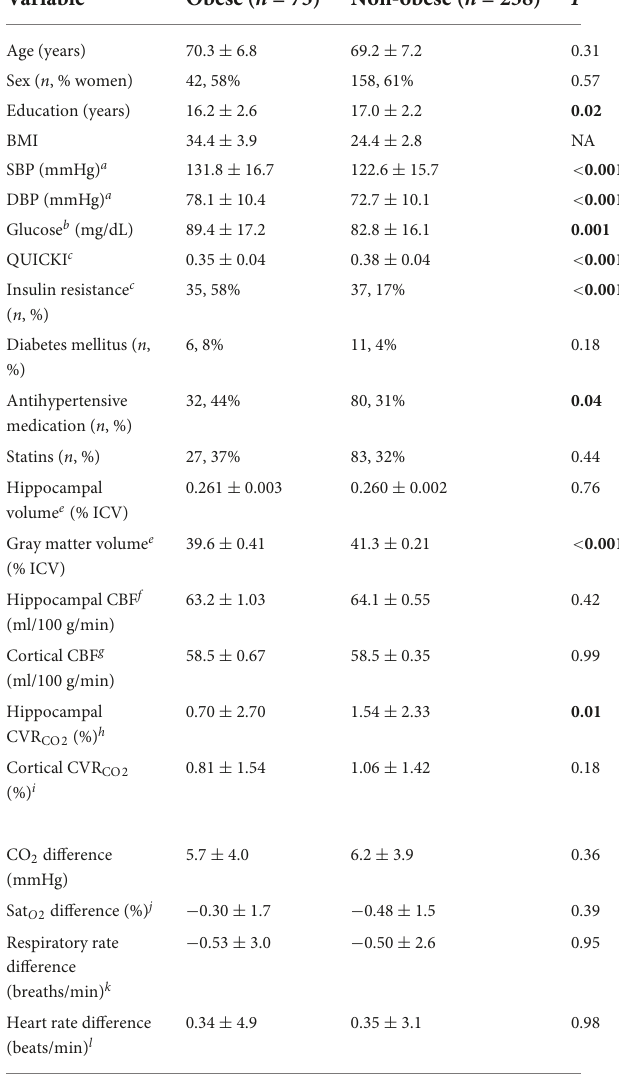
TABLE 1 Baseline characteristics of the study group ( n = 331), by obese